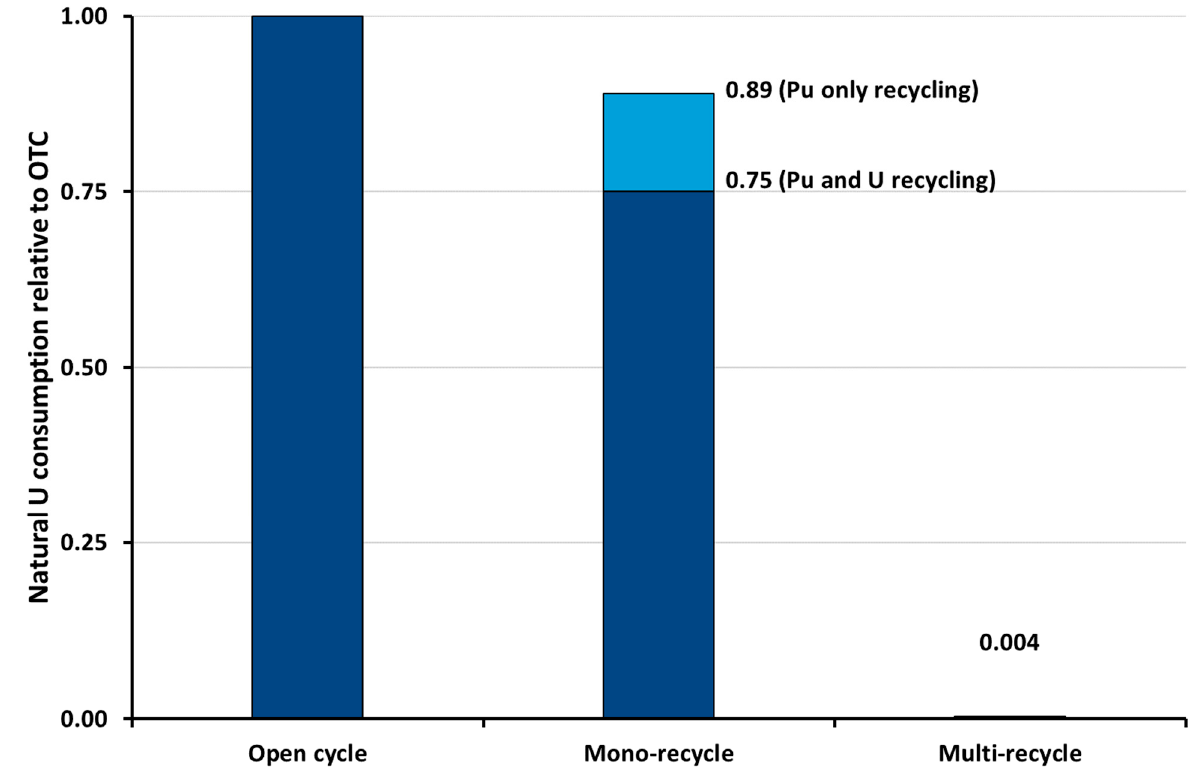
Figure 4. Natural uranium consumption relative to the OTC. Redrawn from data in [55]. The question of uranium resource management was addressed from a global perspective by the OECD-NEA [34]. They simulated the impacts of global growth in nuclear energy from (a) a homogenised view of the world and (b) a macro-regional approach based on four groups taken from the Intergovernmental Panel on Climate Change (IPCC):